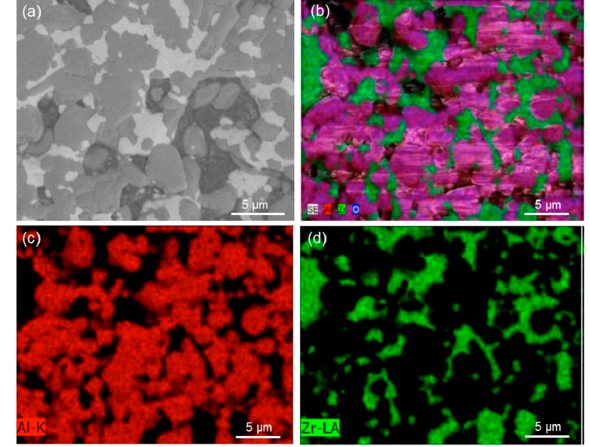
Figure 7. Morphological and compositional analyses of the sintered composite ceramics: ( a ) SEM micrograph and ( b ) compositional map achieved by energy dispersive X-ray spectroscopy (EDS), ( c ) and ( d ) show the distribution of Al (red) and Zr (green), respectively, with reference to the image ( b ).